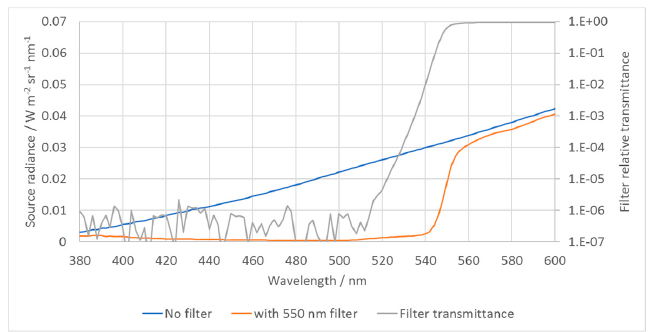
Figure A2. Stray light during calibration as a percentage of the measured signal. The results in Figure A2 show that external stray light is small during calibration (less than ~0.1). When the instrument is used in the field, the stray light signal will be much higher because the surrounding area is brightly illuminated. For now, we consider an uncertainty associated with external stray light to be 0.1%, recognizing that this is a rough estimate. Further tests are required with sources of differing sizes and with in-the-field stray light testing in order to refine this estimate. B2. Internal (Spectral) Stray Light Internal stray light is light that scatters within the spectrometer and therefore reaches a spectrometer pixel for the “wrong” wavelength. This is particularly problematic at short wavelengths where the desired signal is small and the detector has a higher sensitivity to light of longer wavelengths than it does to light of the desired wavelength. These two effects combine to mean that a small fraction of light from the much higher radiance longer wavelengths can significantly impact the measured signal at short wavelengths. This internal spectral stray light was estimated using long-pass filters, which do not transmit light below a cut-on wavelength and have a high transmittance for longer wavelengths. The signal with the filter was compared to the signal without the filter for the shorter wavelengths. Figure A3 shows the signal with and without a 550 nm cut-on filter. At the shortest wavelengths (below 440 nm), the signal with a filter rises and is almost half of the (low) signal with a filter.